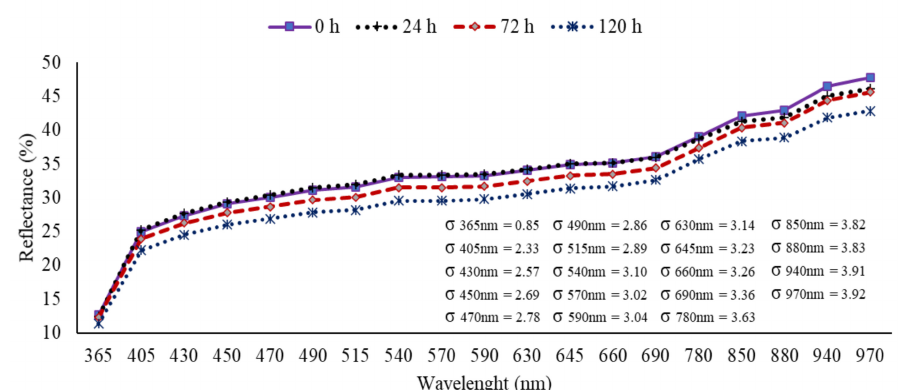
Figure 2. Mean spectral reflectance signatures measured at 19 wavelengths for non-inoculated seeds (0 h) and inoculated seeds with Drechslera avenae (Eidam) Sharif, at 24, 72 and 120 h after inoculation. σ represents the standard deviation ( +/ − ) of reflectance data in each wavelength.